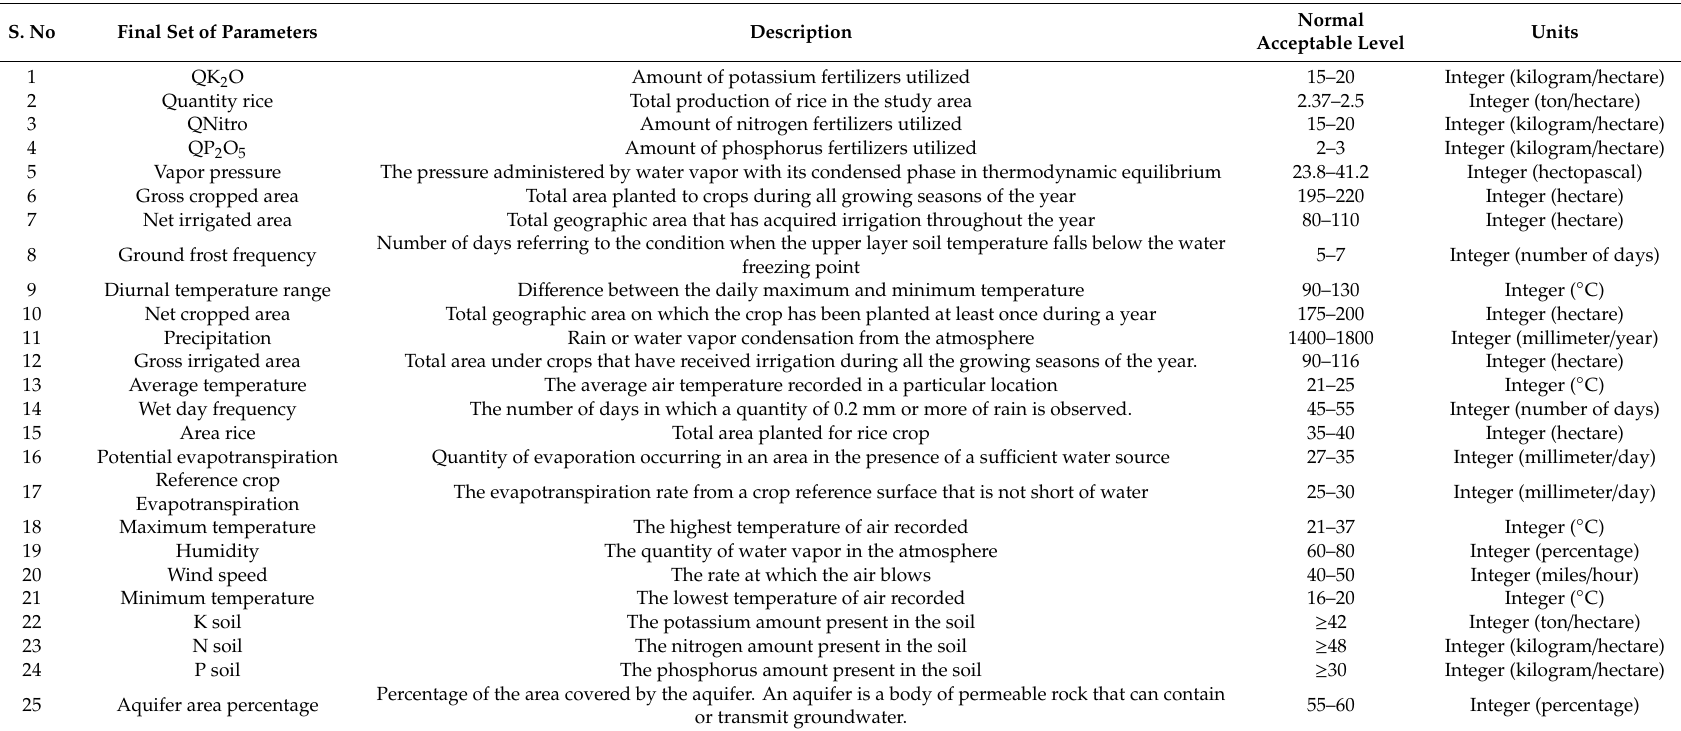
Table 7. List of dataset parameters after the proposed hybrid feature selection